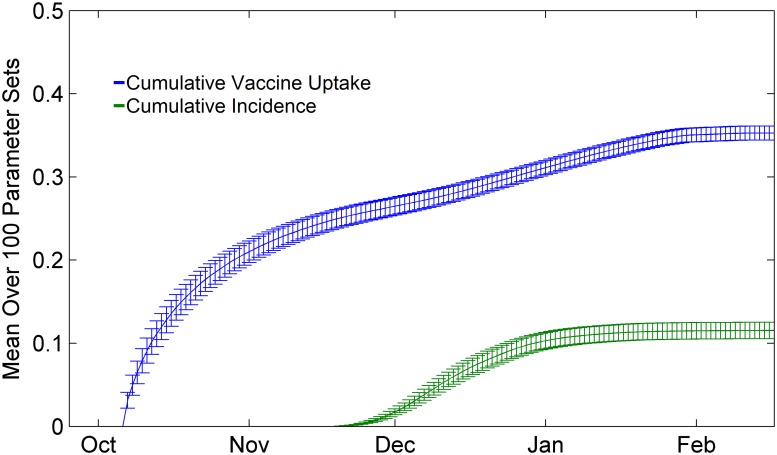
Seasonal time series.Example time series of vaccination (blue) and incidence (green) over a season. When a vaccine becomes available in early October, uptake increases in anticipation of the upcoming influenza season. Confidence intervals represent two standard deviations of outputs for the 100 parameter sets (see Model Calibration section).